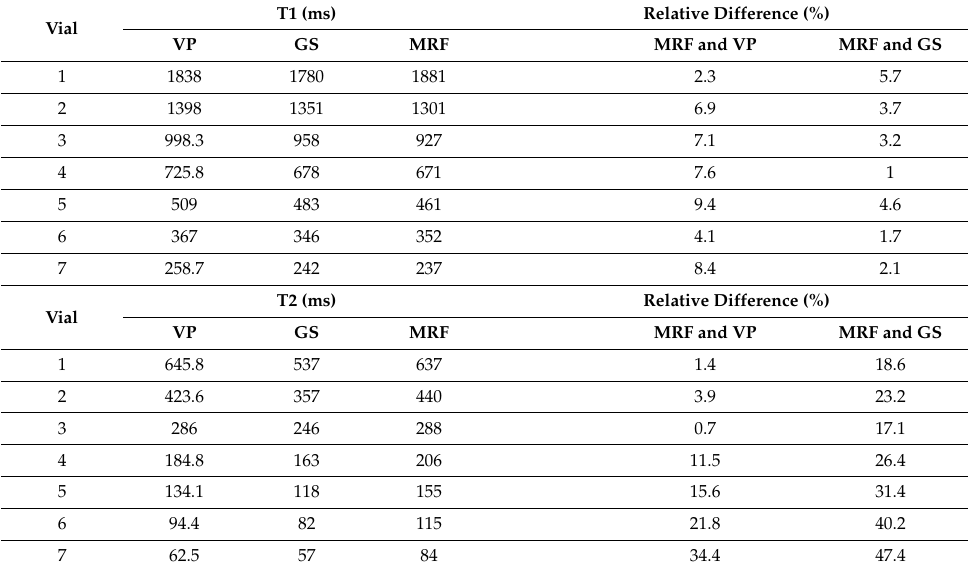
Table 2. Estimated T1 and T2 values from three different methods using MRI system phantom.